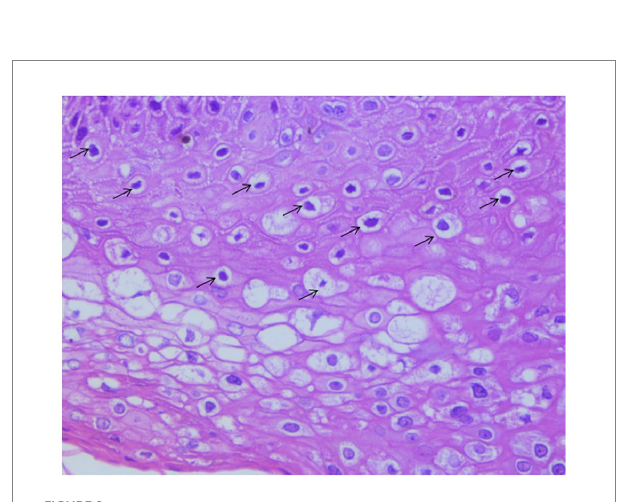
FIGURE 2 Representative image of H&E staining of the wart xenograft. Magnification, × 400. Koilocytes were important indicators for condyloma acuminatum. As arrows shown in this figure, koilocytes were observed in the granular layer and the upper part of the spinous layer. That means the CA model was successful to use in the next experiments.